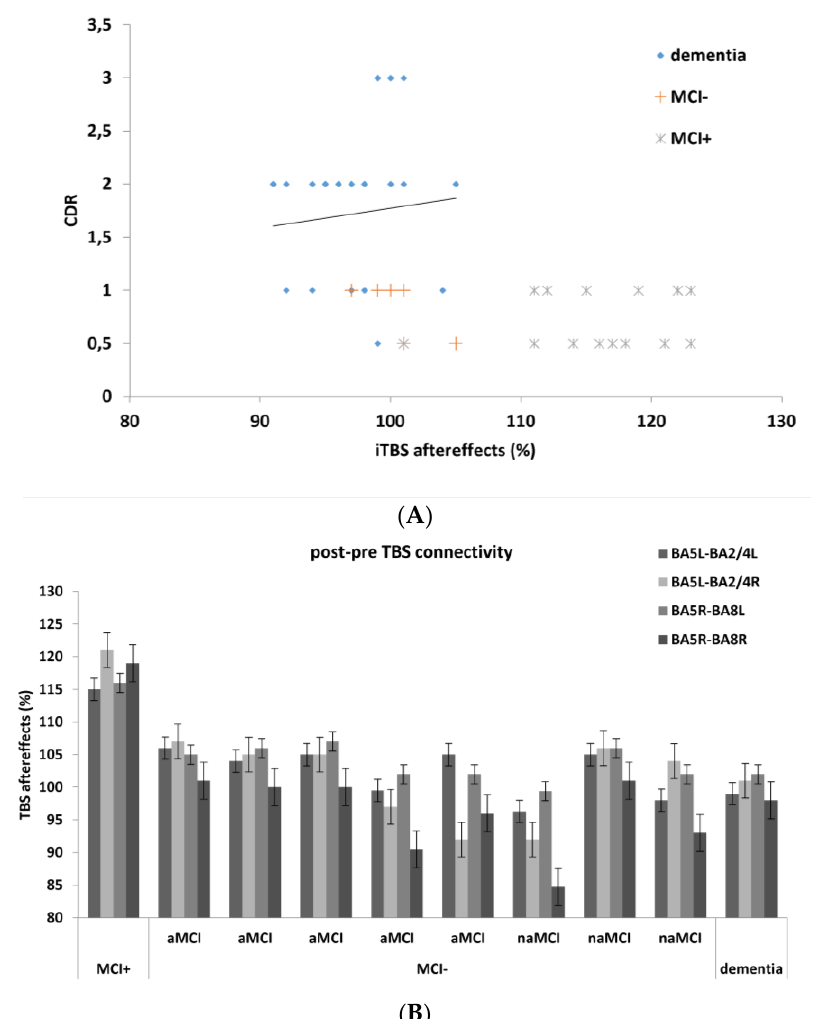
Figure 4. ( A ) shows the scattergram of the correlation between overall cognitive profile (CDR Clinical Dementia Rating scale) and overall intermittent Theta-Burst Stimulation (iTBS) aftereffects (%) in patients with dementia and MCI. ( B ) Among the patients with MCI- (non-responsive to iTBS), aMCI did not significantly differ from the naMCI with regard to the four significant edges and, in particular, to BA5-BA8 theta and low-alpha (5–8 Hz) connectivity.